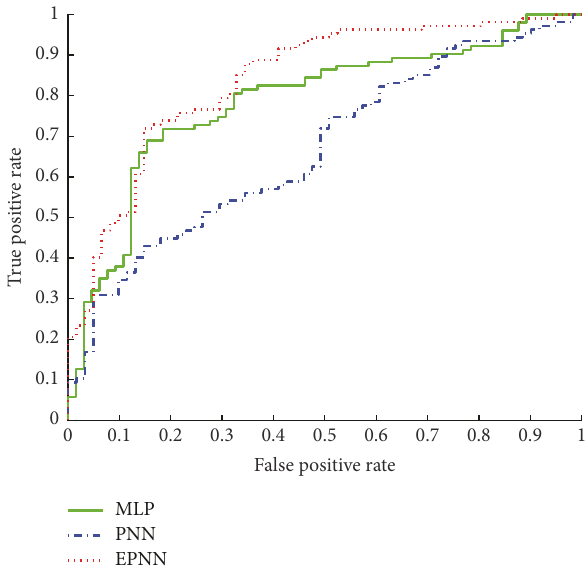
Figure 7: The ROC of the Distress data